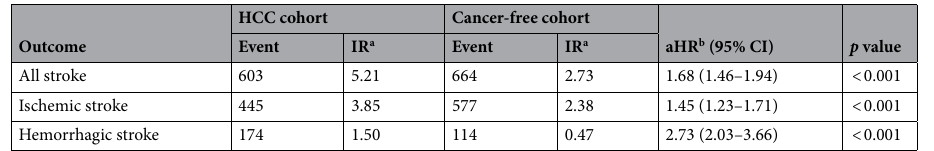
Table 4. Risk of stroke in patients with hepatocellular carcinoma compared with the cancer-free cohort without propensity score matching. aHR adjusted hazard ratio, CI confidence interval, CCI Charlson comorbidity index, HCC hepatocellular carcinoma, IR incidence rate. a IR per 1000 person-years. b The hazard ratios were calculated using a multivariable Cox proportional hazards regression model with adjustments for income, CCI, comorbidities, and medication use listed in Table 1.